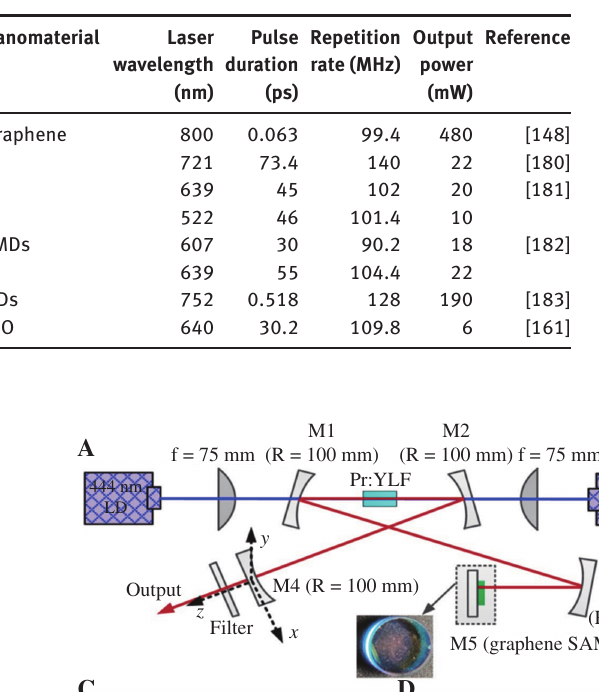
Table 3: Summary of reported mode-locked solid-state crystal lasers based on nanomaterial-based SAs.